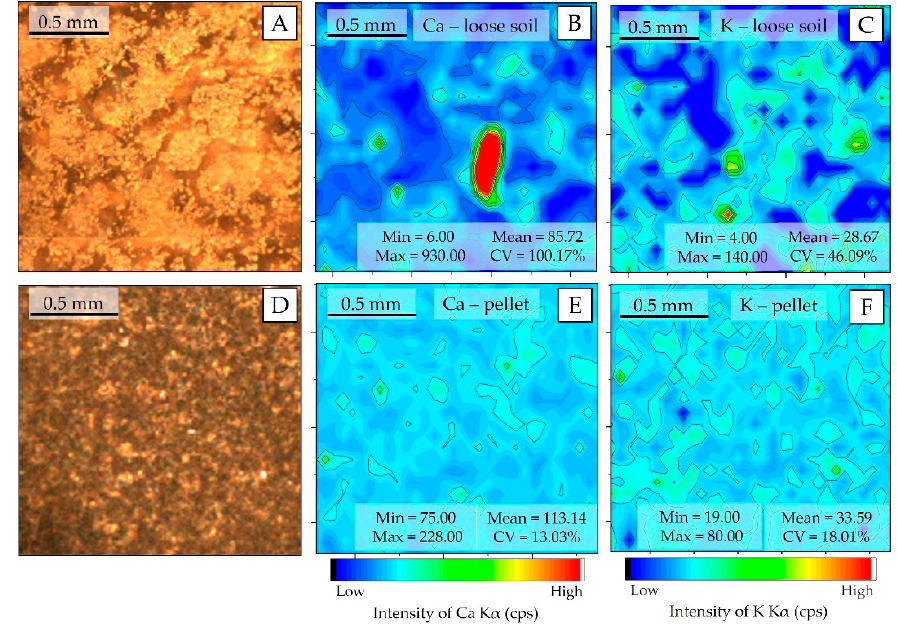
Figure 4. µ -XRF chemical images showing the spatial distribution of Ca and K in the loose soil ( B and C , respectively); Ca and K in the pellet ( E and F , respectively). Photo of the analyzed area of ( A ); the loose soil ( A ) and pellet ( D ).